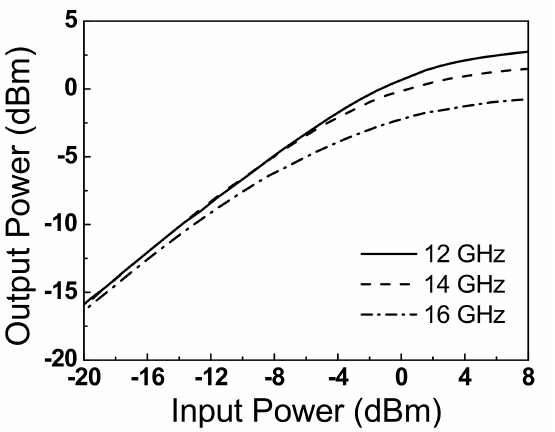
Figure 16. Measured output power of the Ku-band CMOS transmit and receive IC in Tx